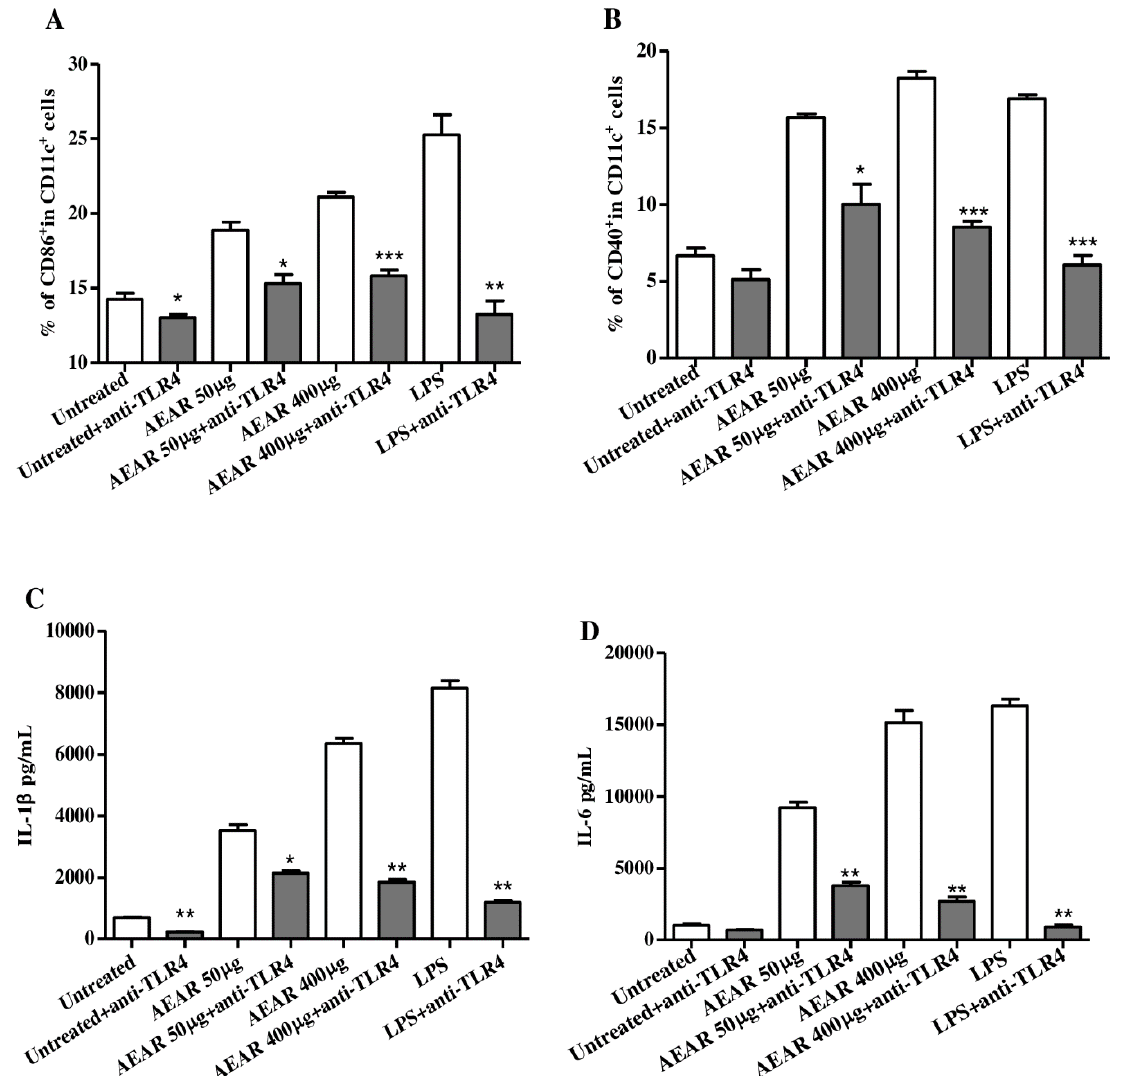
Figure 8. TLR4 ‐ dependent activation of DCs by AEAR. The activation of DCs was blocked by anti ‐ TLR4 antibody. ( A–B ) Expression levels of CD86 and CD40. ( C–D ) Production of IL ‐ 1 β and IL ‐ 6. The values are expressed as means ± SD ( n = 3 ) . * p < 0.05, ** p < 0.01, and *** p < 0.001 indicate significant differences compared with the group treated by AEAR alone, determined by one ‐ way analysis of variance (ANOVA) and Tukey’s multiple ‐ comparison